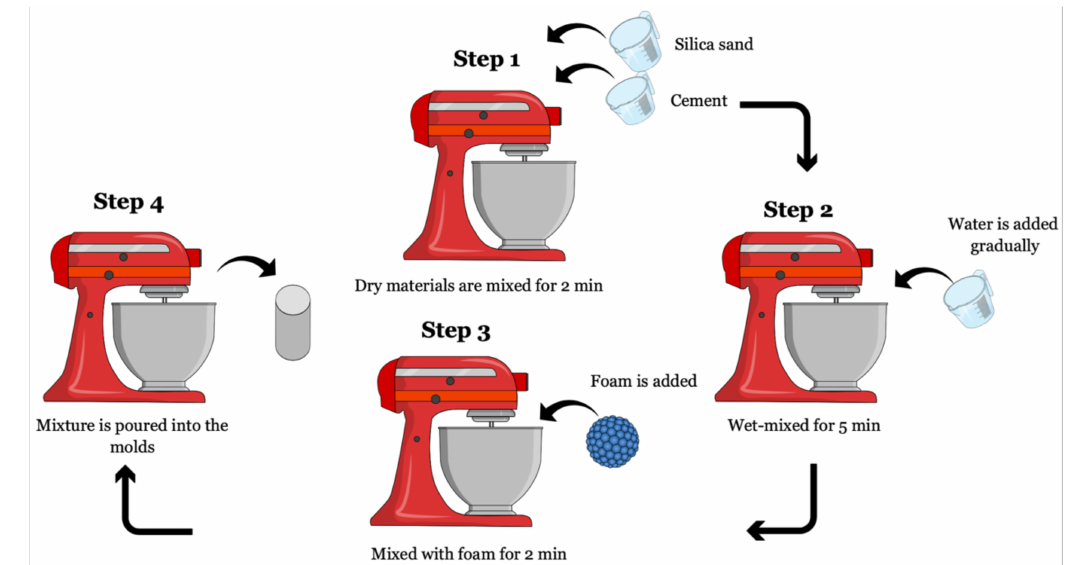
Figure 6. Preparation of backfill mixtures.